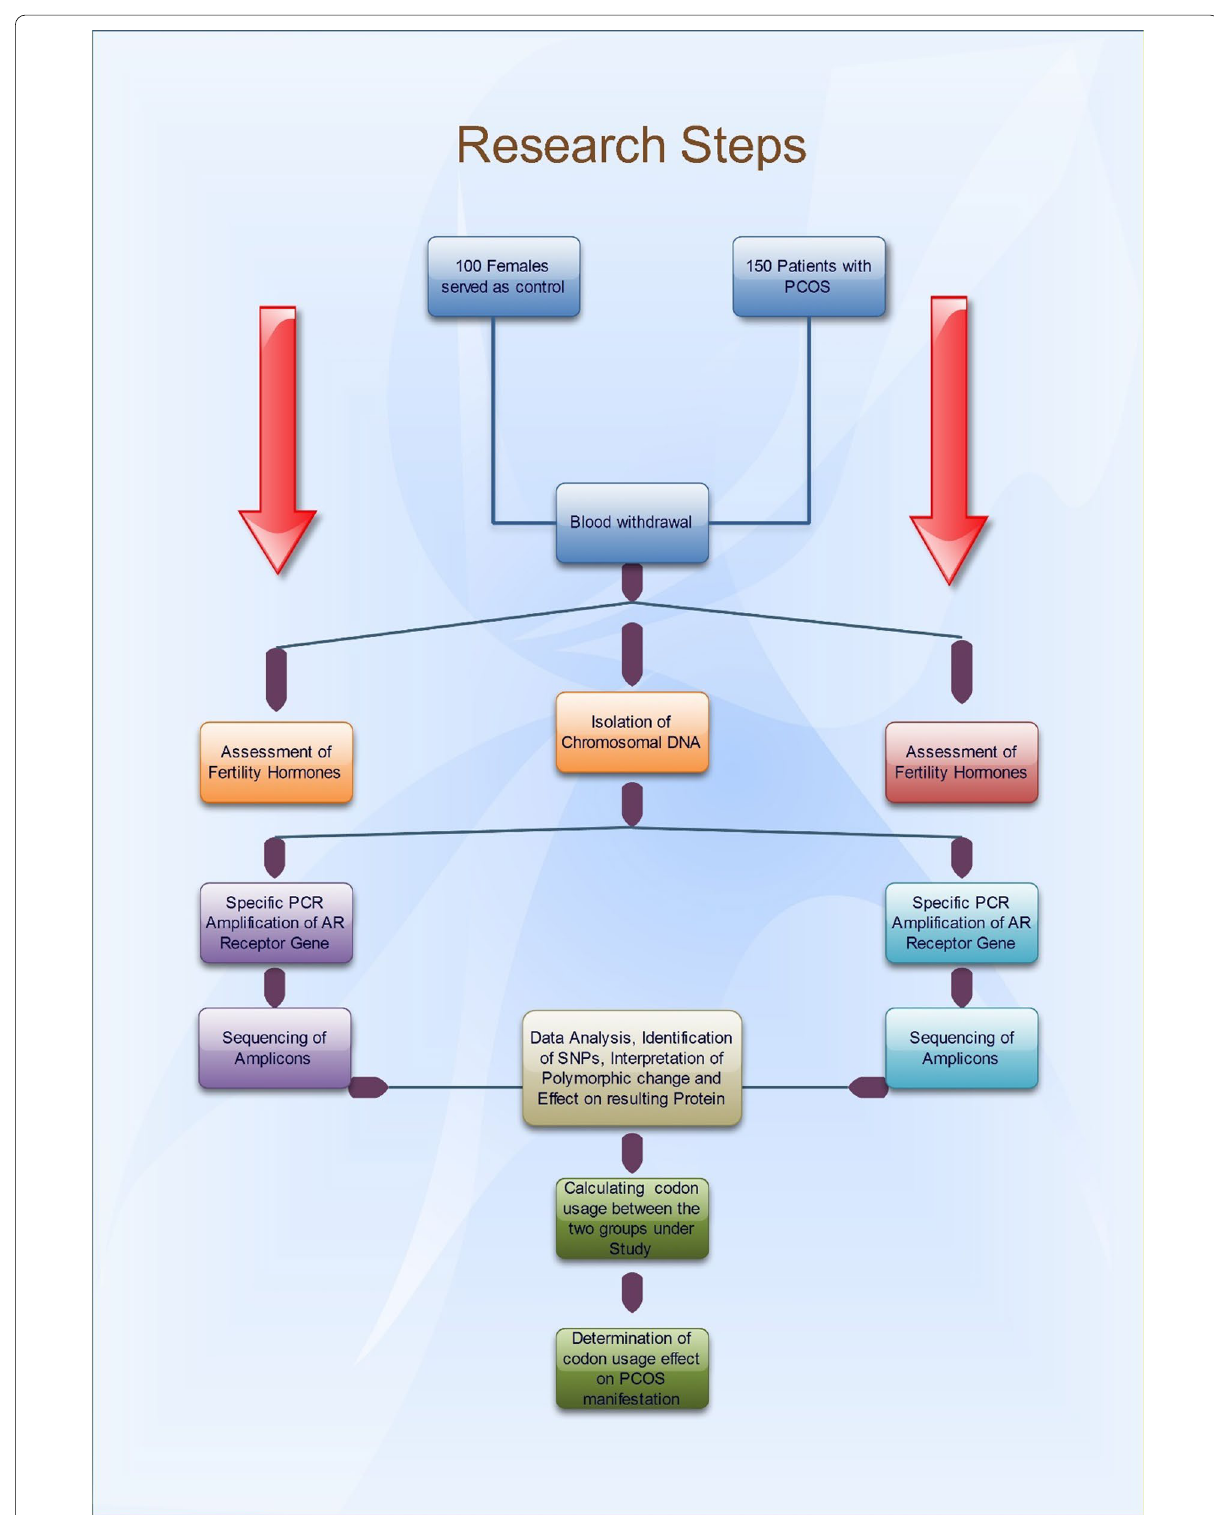
Fig. 1 Flowchart showing research steps, participants, and main goal of this